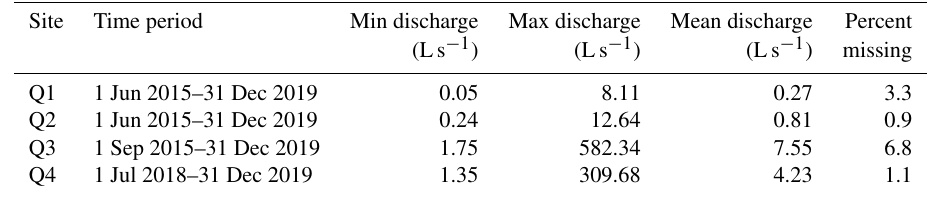
Table 3. Statistics of discharge records and of missing data.